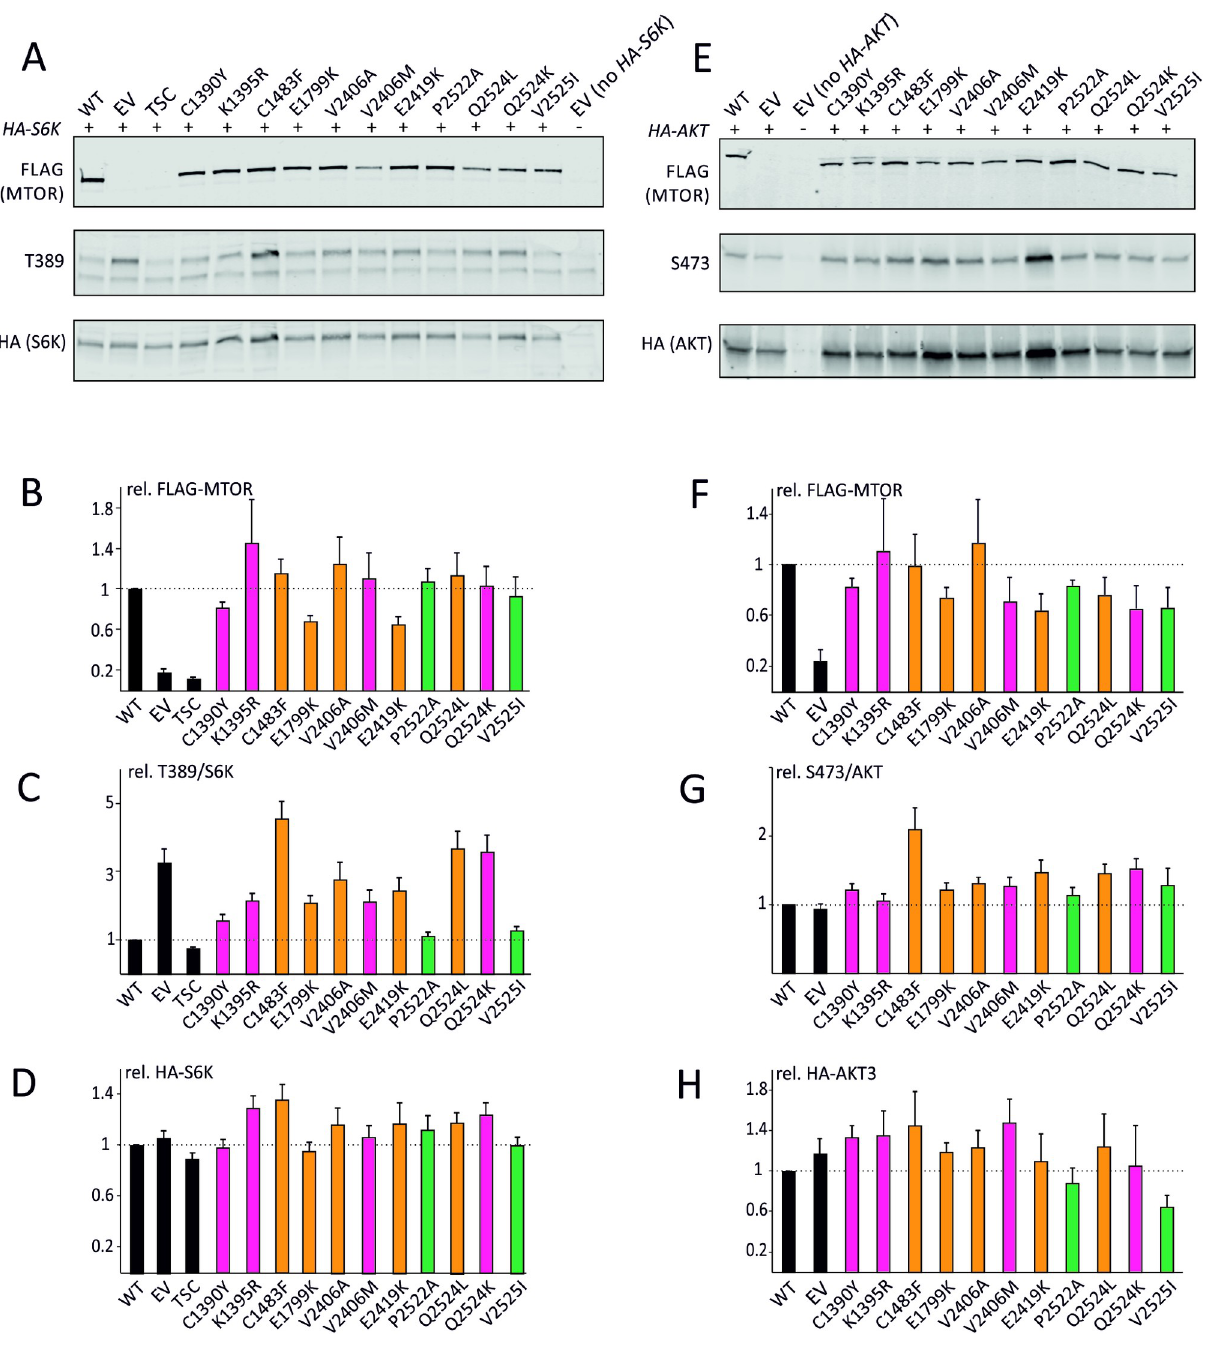
Fig 1. Novel Smith-Kingsmore Syndrome Variants Activate MTORC1 and MTORC2 in Stimulated and Serum-starved Human Embryonic Kidney Cells. (A) An example of an immunoblot is shown. (B) Expression levels of the FLAG-MTOR variants were determined using an antibody specific for the FLAG epitope. (C) To estimate TORC1 activity, the ratio of T389-phosphorylated S6K (T389) to total HA-S6K was determined, relative to the ratio for wild-type MTOR (T389/S6K; = 1.0). (D) The total HA-S6K signal was used to estimate the transfection efficiency. (E) An example of an immunoblot is shown. (F) Expression levels of the FLAG-MTOR variants were determined using an antibody specific for the FLAG epitope. (G) To estimate MTORC2 activity, the ratio of S473-phosphorylated AKT3 (S473) to total HA-AKT3 was determined, relative to the ratio for wild-type MTOR (S473/ AKT = 1.0). (H) The total HA-AKT3 signal was used to estimate the transfection efficiency.